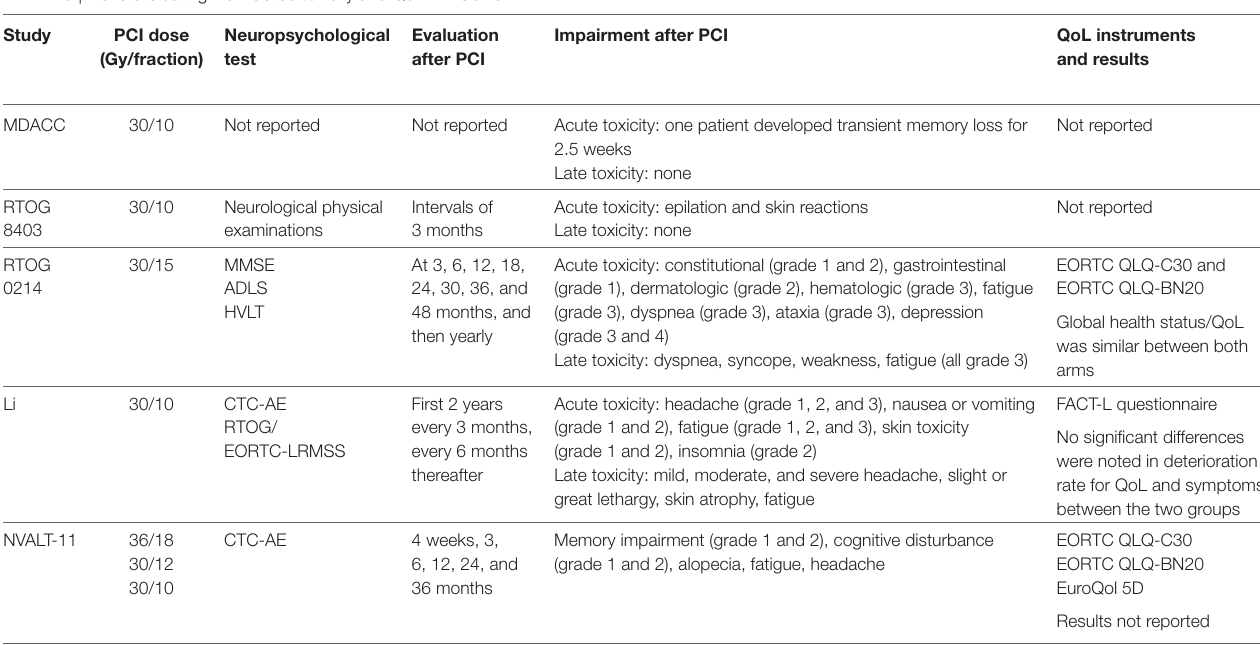
TABLe 3 | RCTs evaluating PCI-related toxicity and QoL in